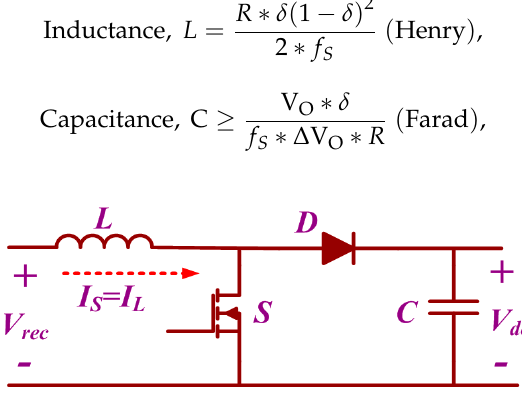
Figure 3. Power Circuit of Boost Converter.